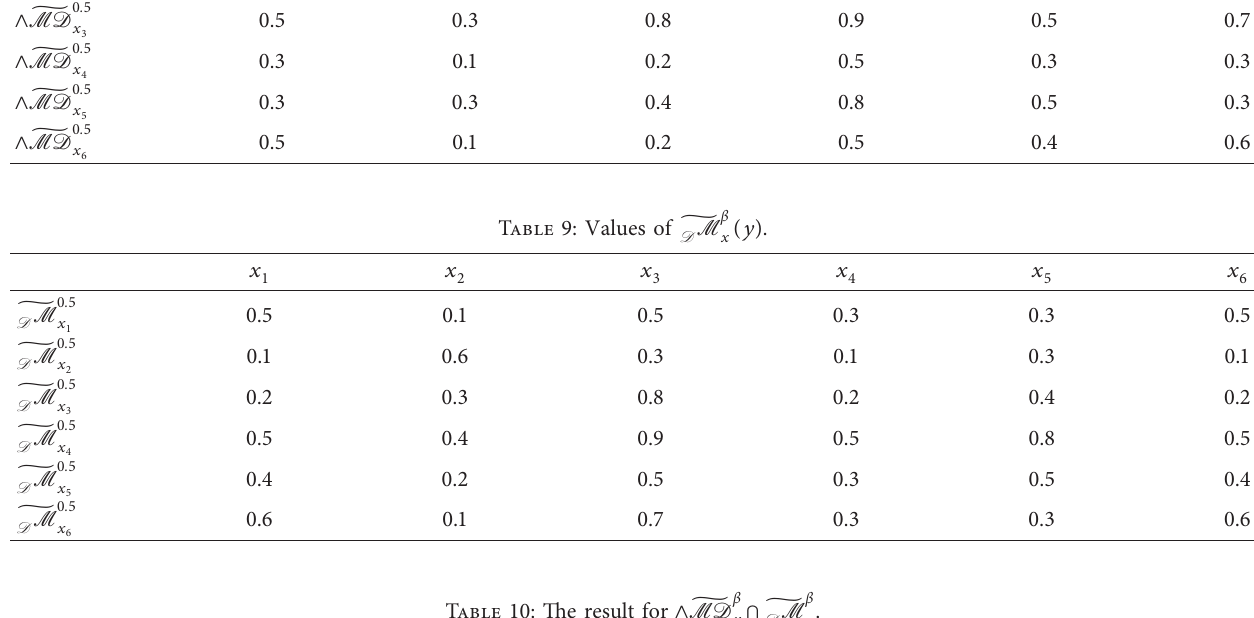
Table 10: The result for ∧ 􏽧 MD β